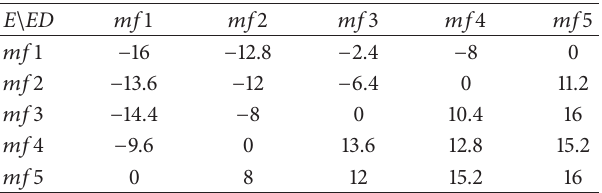
Table 3: Rule weight values of FPD PID